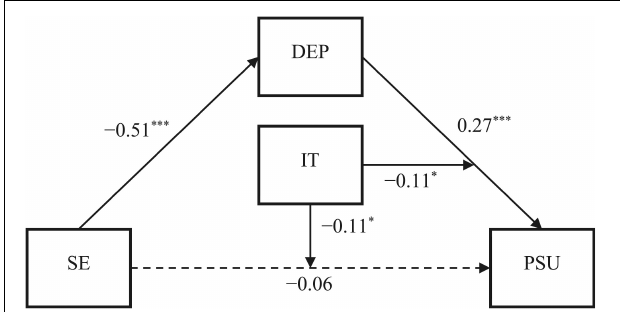
FIGURE 1 | The moderated mediation model controlling for age and gender (all coefficients standardized). SE, self-esteem; DEP, depression; PSU, problematic smartphone use; IT, interpersonal trust. ∗ p < 0.05; ∗∗∗ p <